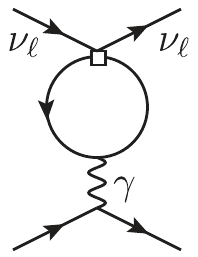
Figure 2 . Closed fermion loop contribution to neutral-current neutrino scattering. This diagram includes both charged and neutral currents cf. figure 1. Heavy fermion loops, with masses above the renormalization scale, are included implicitly in the four-fermion Wilson coefficients. The effects of the light fermion loops (i.e. e, µ, τ and u, d, s, c ) can be captured by taking tree-level